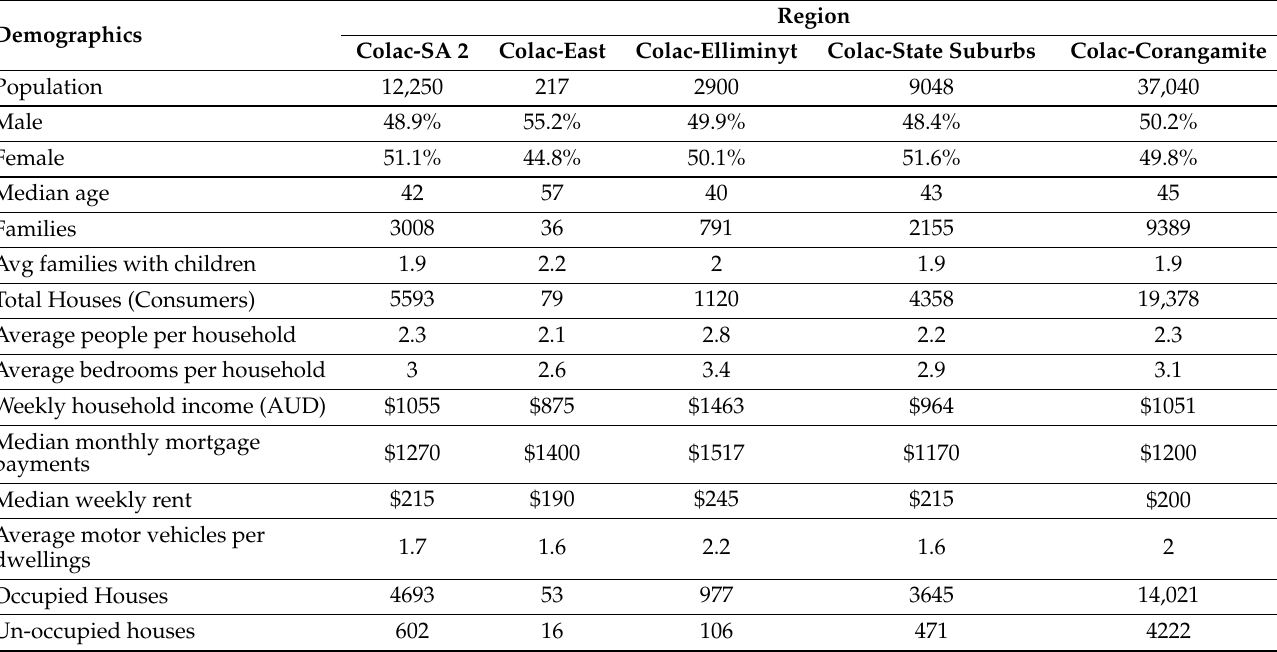
Table 2. Demographic factors of households collected from local government